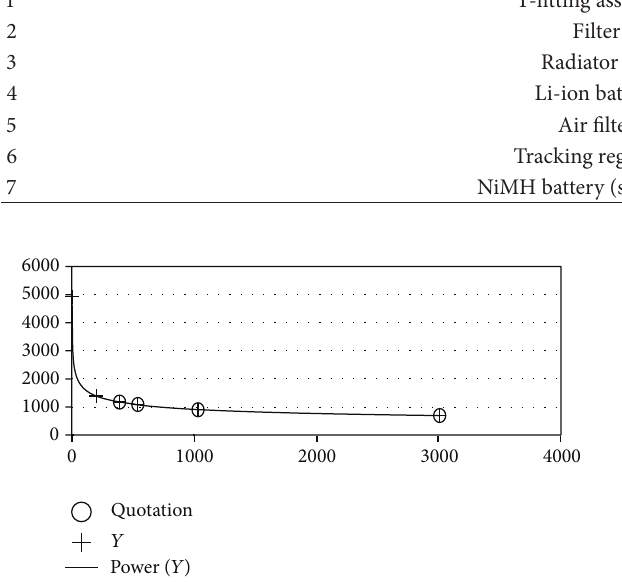
Figure 5: Graph of quotation price versus learning model price for air